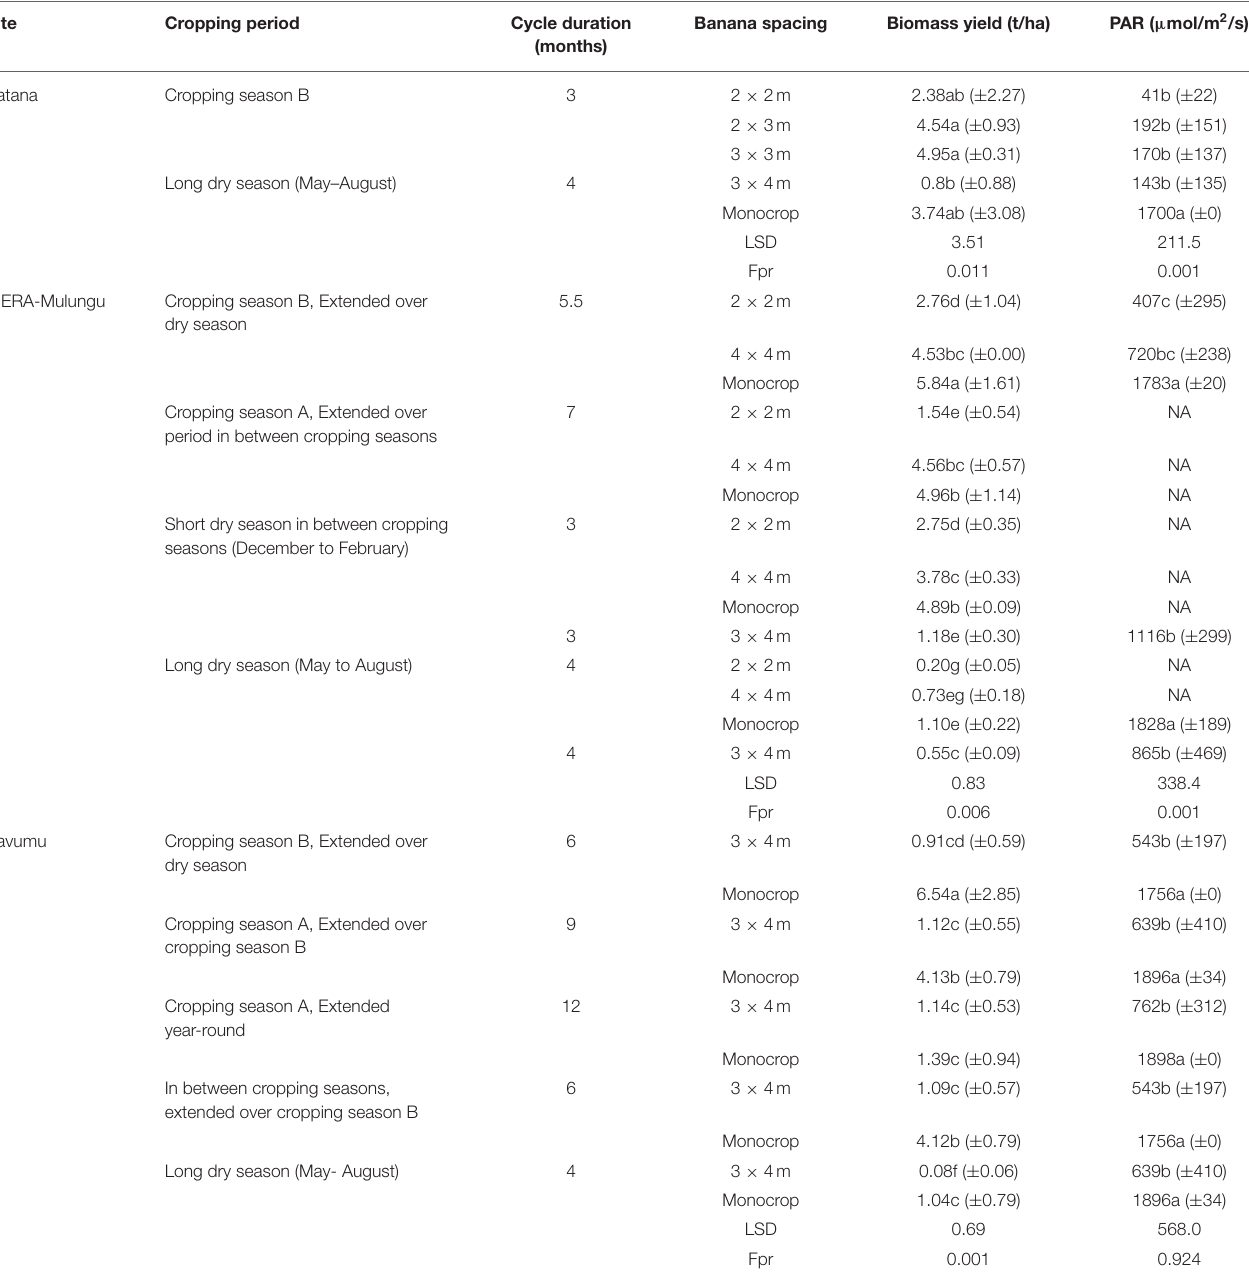
TABLE 4 | Mucuna biomass yields across the sites INERA-Mulungu, Kavumu, and Katana for various cropping periods. Site Cropping period Banana